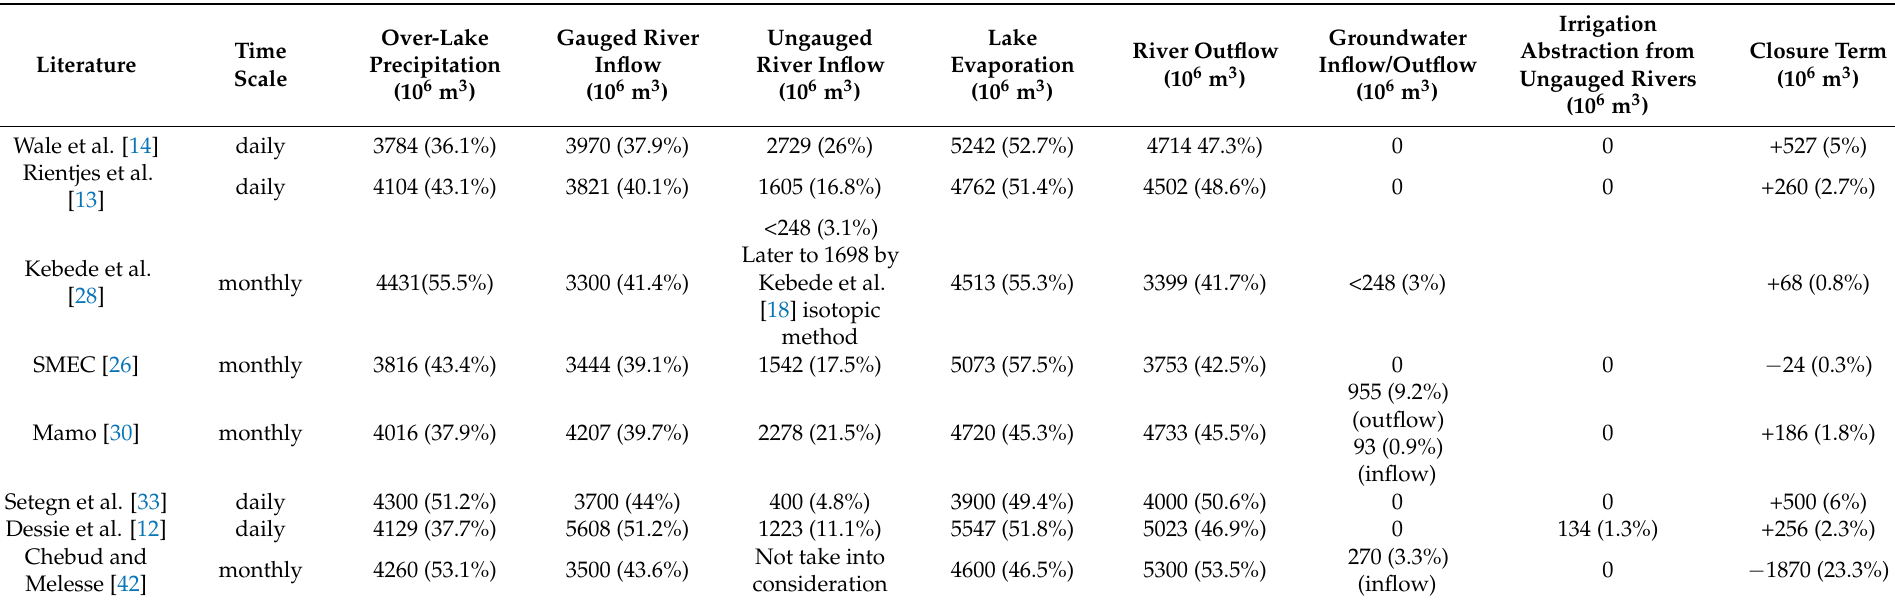
Table 4. Summarized annual estimations for water balance terms of Lake Tana by various authors. The change in storage is the difference between the inflows and outflow terms, assuming the inflow positive and the outflow negative. The percentages are individual terms per total inflows or